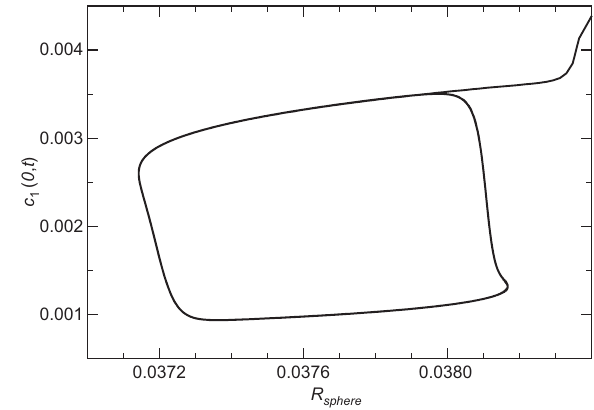
Figure 5 Zoom on a period of oscillation of R time sequence for Figures 9 and 10. Figure 8 Limit cycle for c